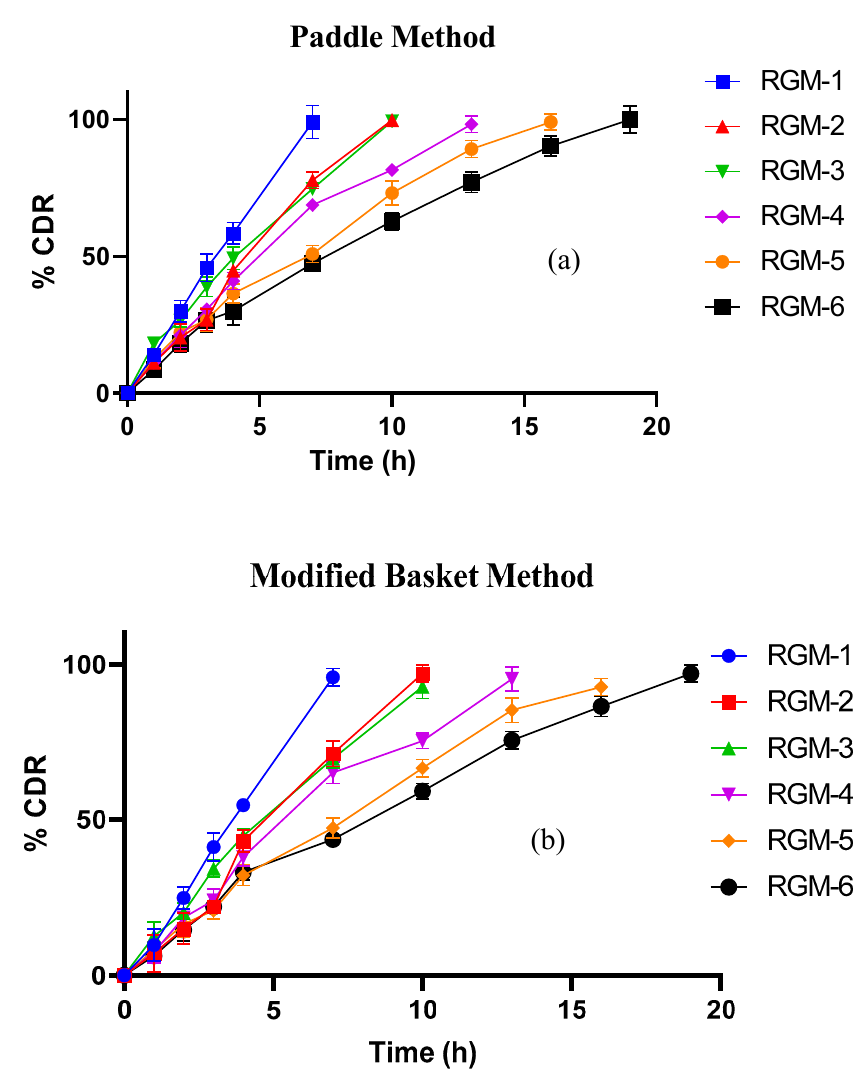
Figure 8. In vitro drug release profile for prepared bathes by ( a ) paddle method and ( b ) modified basket method.